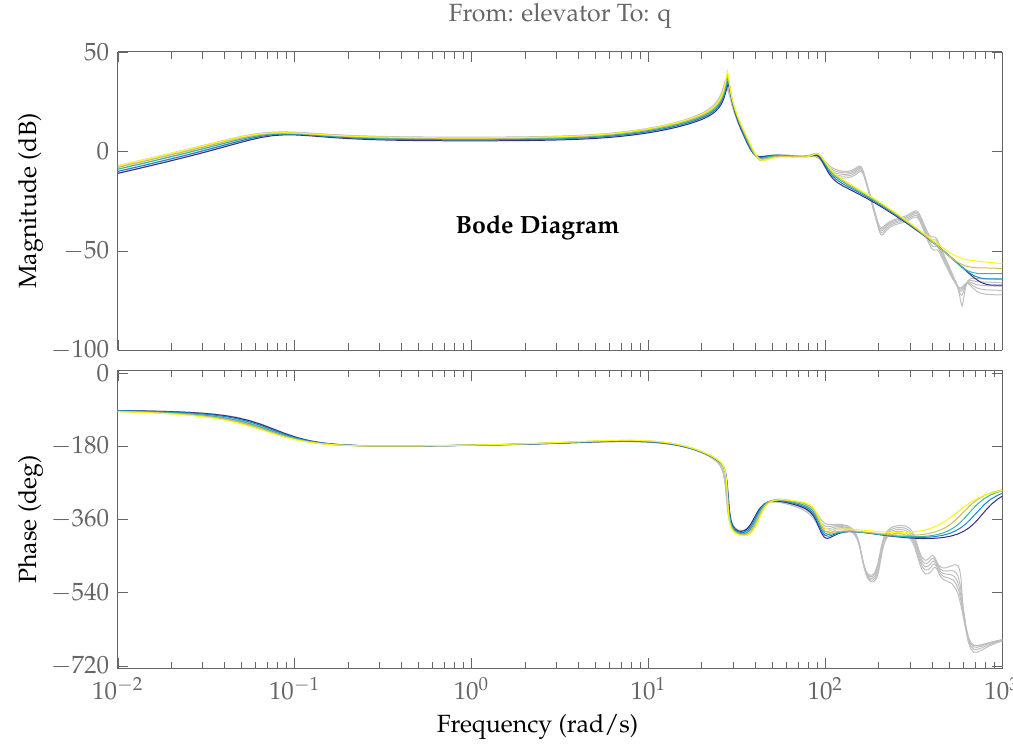
Figure 18. Frequency response of each ’bottom-up’ model compared to the full-order models at V = 25